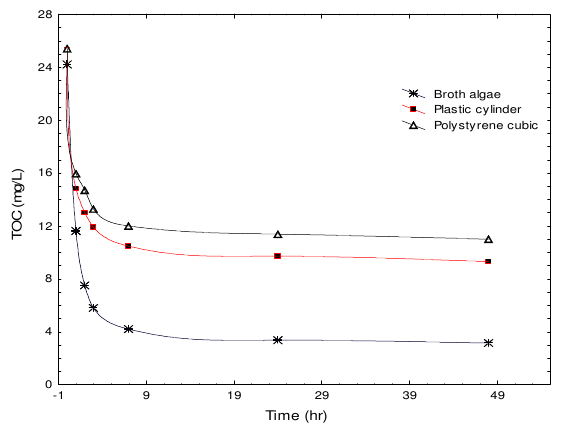
Fig. 14. Effect of Packing type on the concentration level of TOC pollutant with time at T=25 o C, pH 7, and sterilized